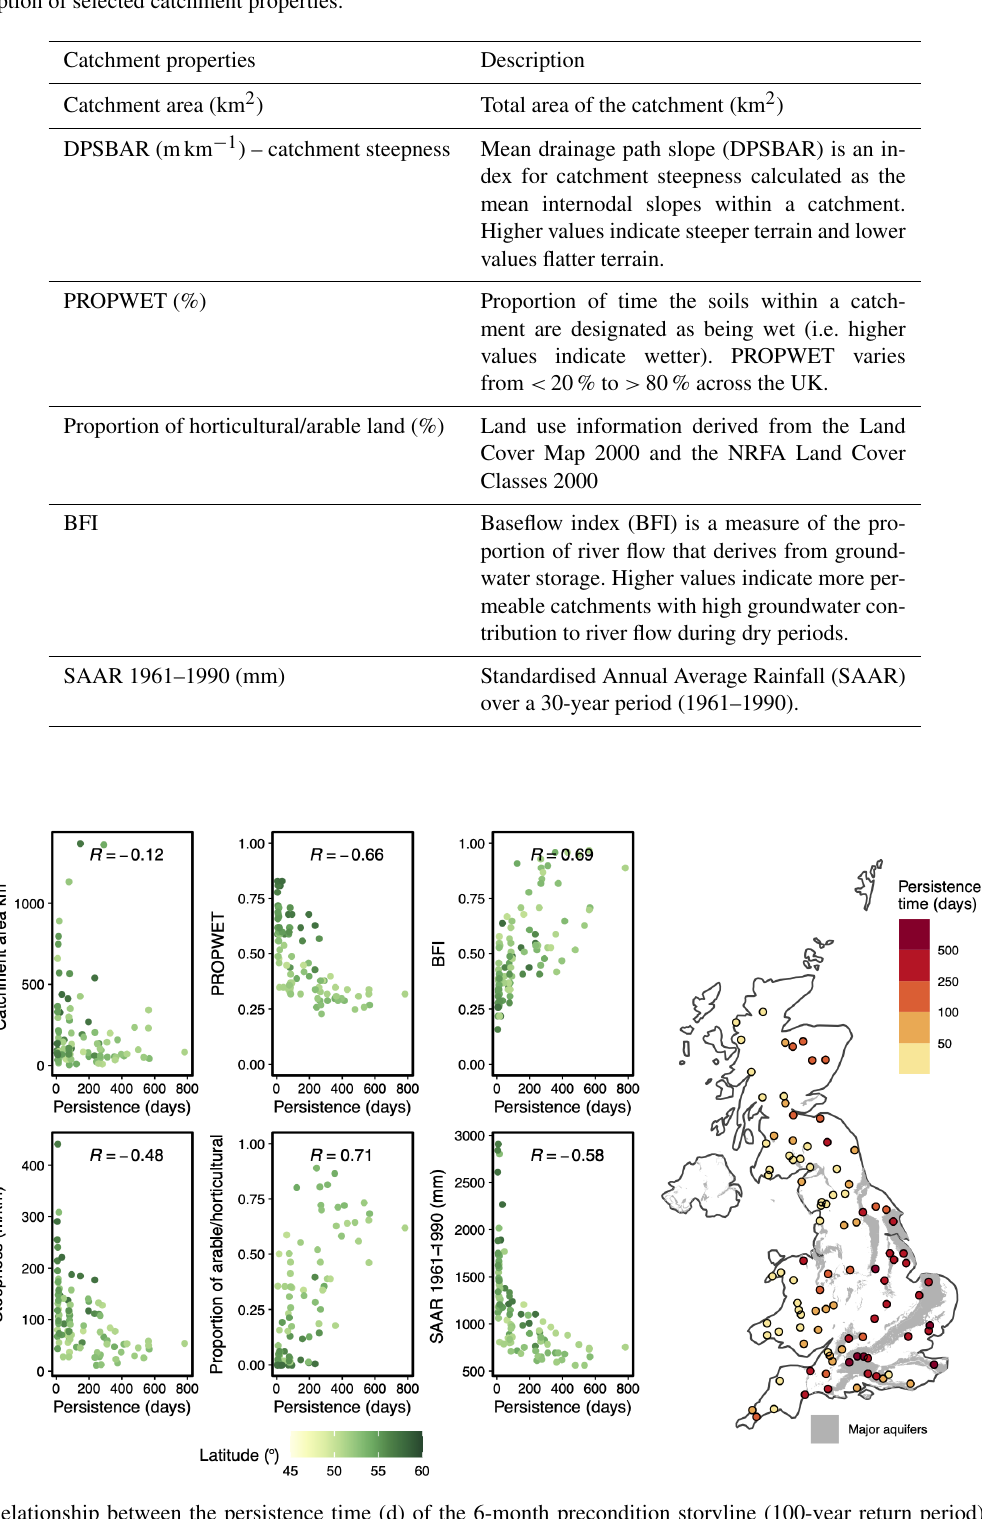
Table 3. Description of selected catchment properties.